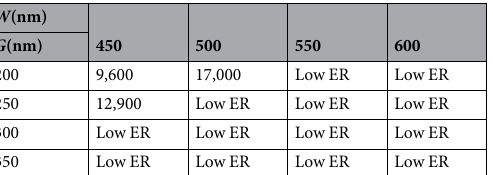
Table 2. Quality factor for ring resonators using the quasi – TE mode with different W and G at 1310 nm.